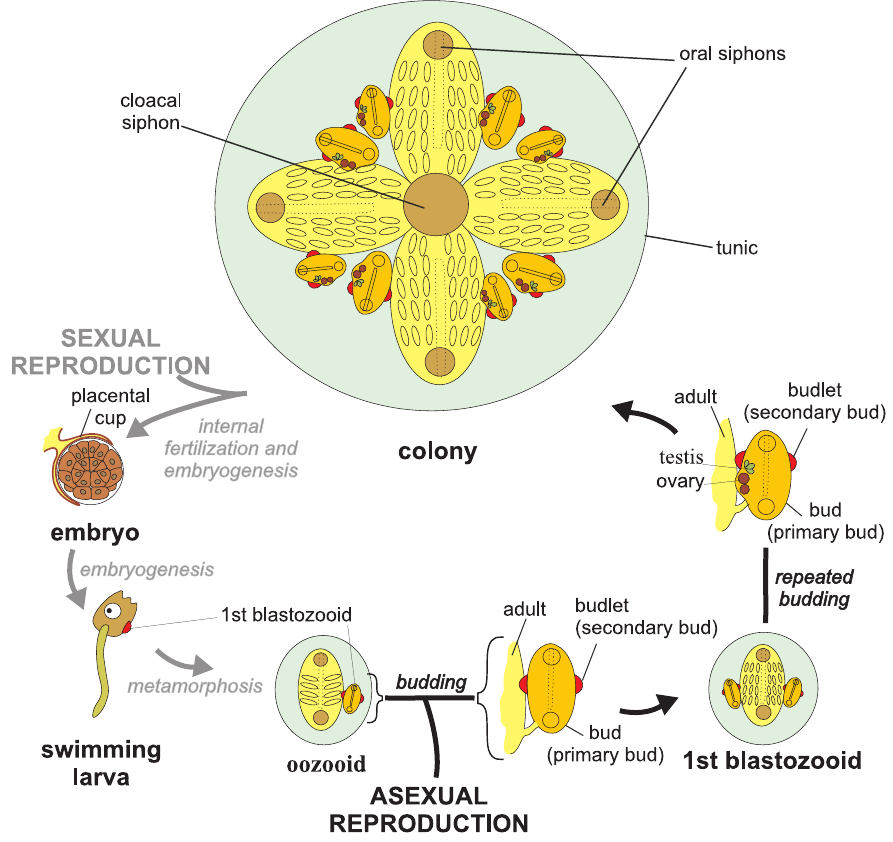
Figure 2. Scheme of Botryllusschlosseri life cycle. Ozooid and blastozooids are shown in a dorsal view. The colony is represented as formed by a single system of four adult blastozooids each bearing two buds, that in turn bear two budlets; all the other drawings represent zooids oriented with the anterior region up; modified from [95].